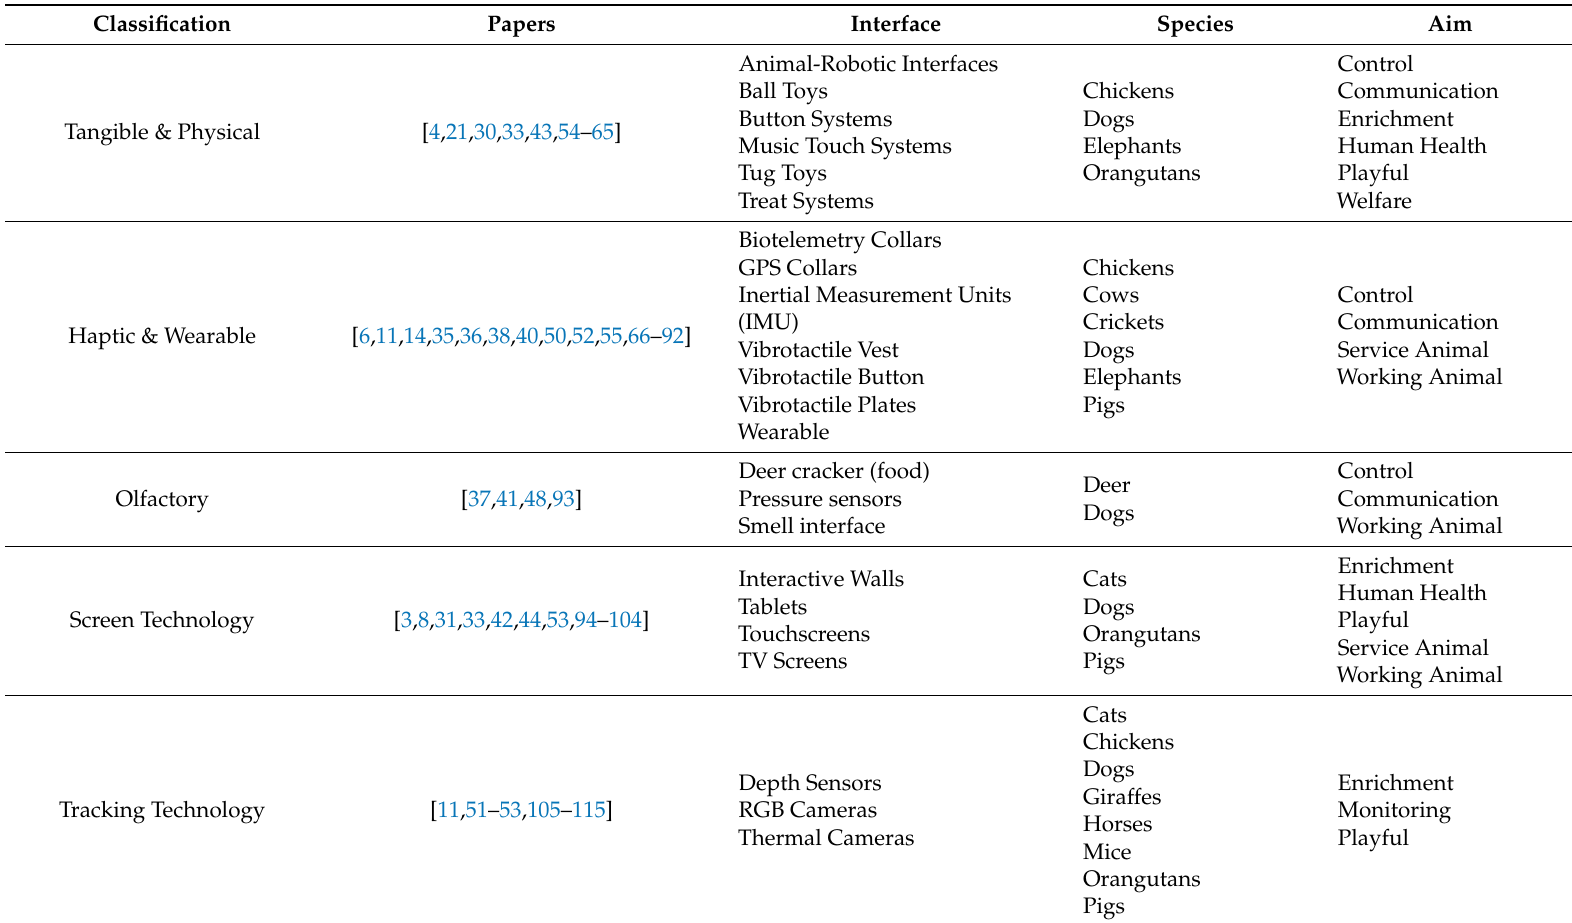
Table 1. Classification of Interactive Technologies in Animal Computer